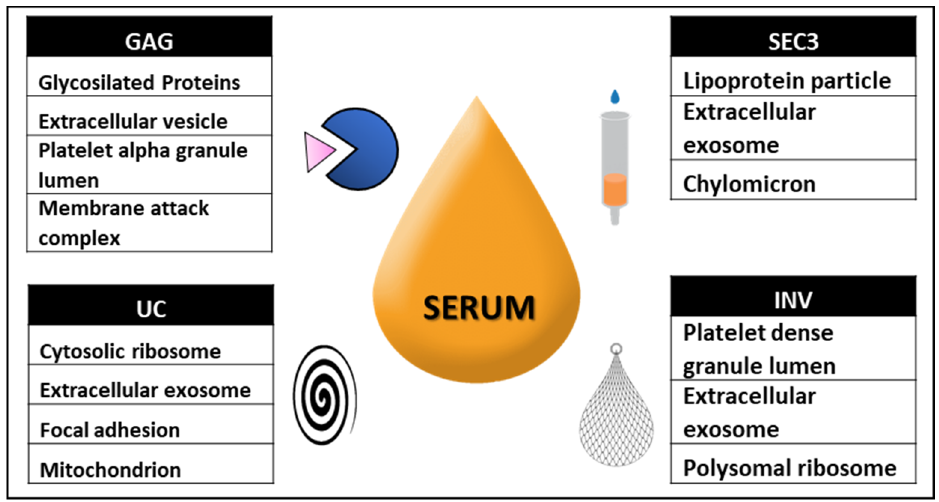
Figure 5. Summary of the cell component analysis associated with the proteins overrepresented in the preparations obtained with different isolation techniques.